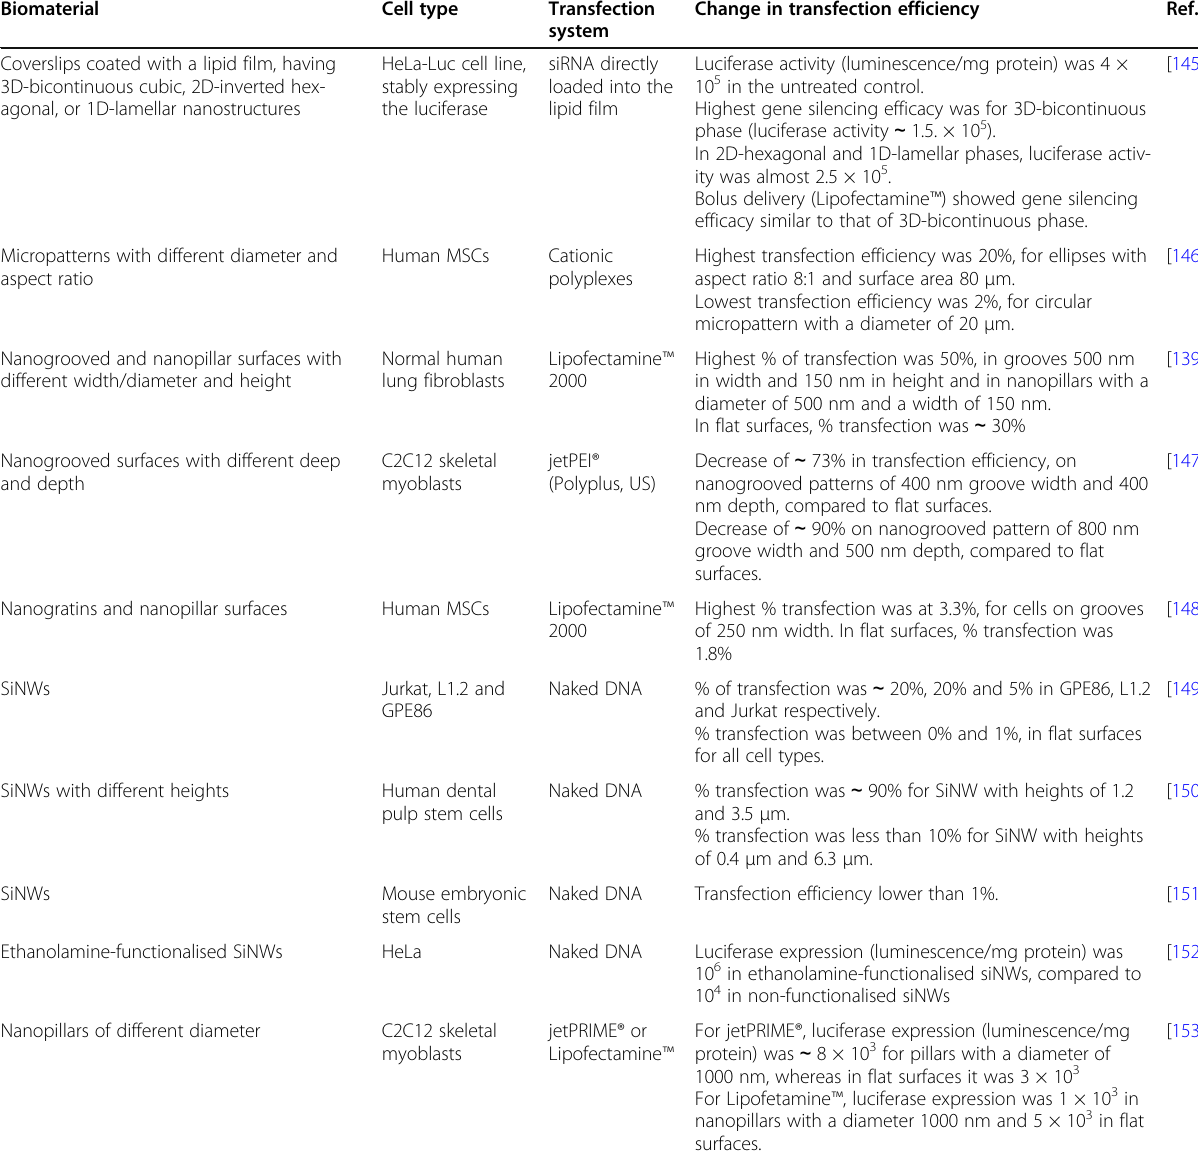
Table 1 Surface topography and gene delivery. Research papers assessing the effect of different surface topographies on surface- mediated non-viral gene delivery